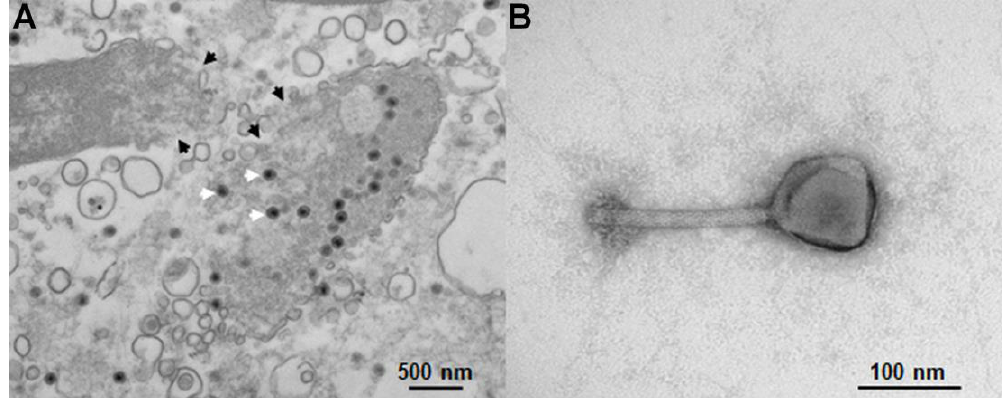
Figure 1. Transmission electron microscopy (TEM) of SPN3US-infected Salmonella and purified SPN3US. ( A ) Negatively stained thin section showing two Salmonella cells in the process of being lysed at the end of infection by SPN3US. Regions of the cell walls undergoing rupture due to phage enzymes are indicated with black arrowheads. Particles of SPN3US progeny are indicated with white arrowheads. Note the extensive amount of cell debris in the sample. ( B ) Negatively stained image of a single SPN3US virion from a preparation that has undergone purification via CsCl gradient ultracentrifugation to remove cellular debris from the sample. SPN3US virions consist of a head (which contains the dsDNA genome) and tail which ends in a complex baseplate that attaches to a Salmonella cell to initiate infection.